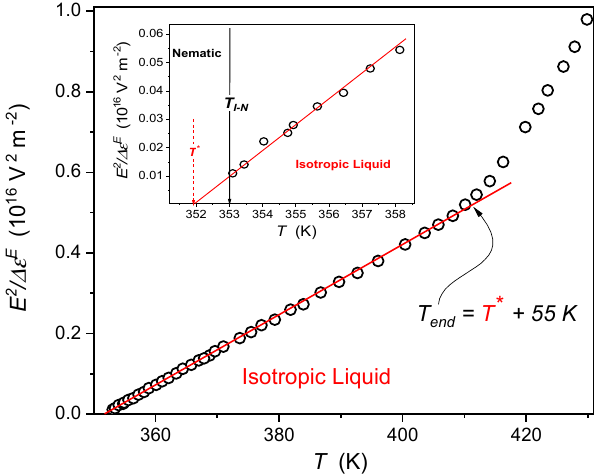
Figure 2. The temperature dependence of the reciprocal of nonlinear dielectric effect (NDE), strong electric field related changes of dielectric constant, in the isotropic liquid phase of liquid crystalline 8OCB. The line shows the validity of portrayal via Equation (4), extending from the Isotropic-Nematic melting temperature to T end . The inset shows the behavior in the immediate vicinity of the I-N melting (clearing) temperature, indicated by the solid arrow. The dashed arrow indicates the hypothetical continuous phase transition.